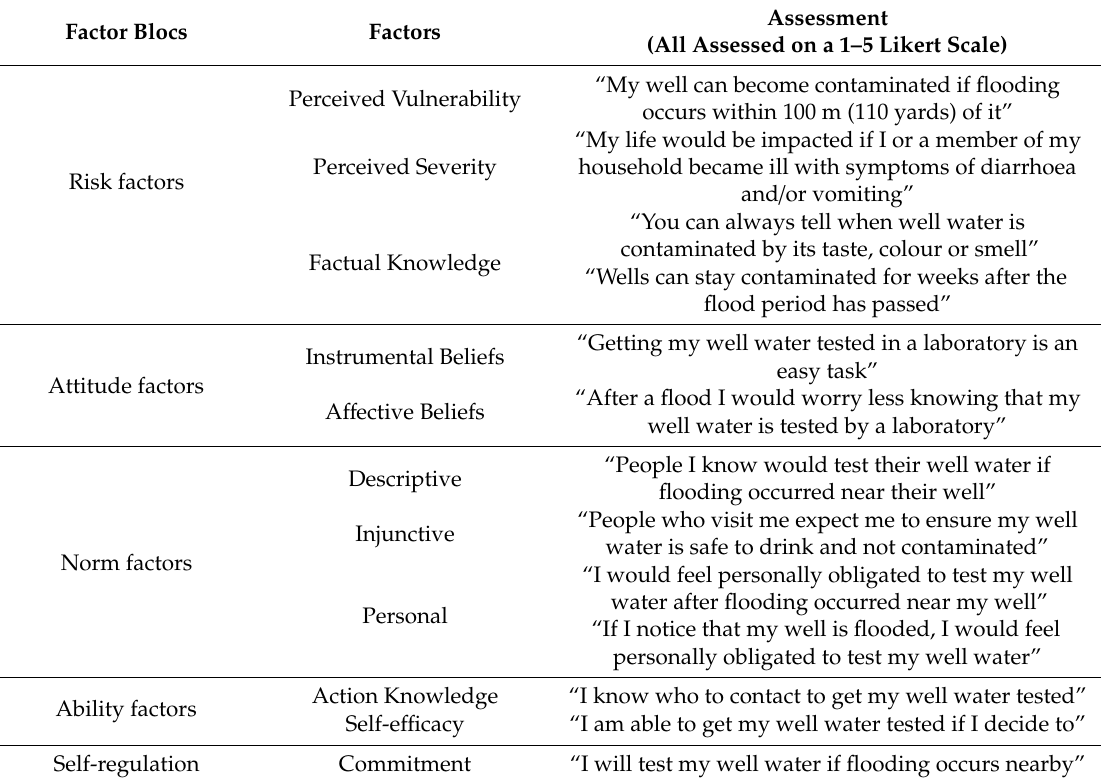
Table 1. Included Risk, Attitude, Norms, Ability, Self-regulation (RANAS) framework factors and their assessment in the survey.